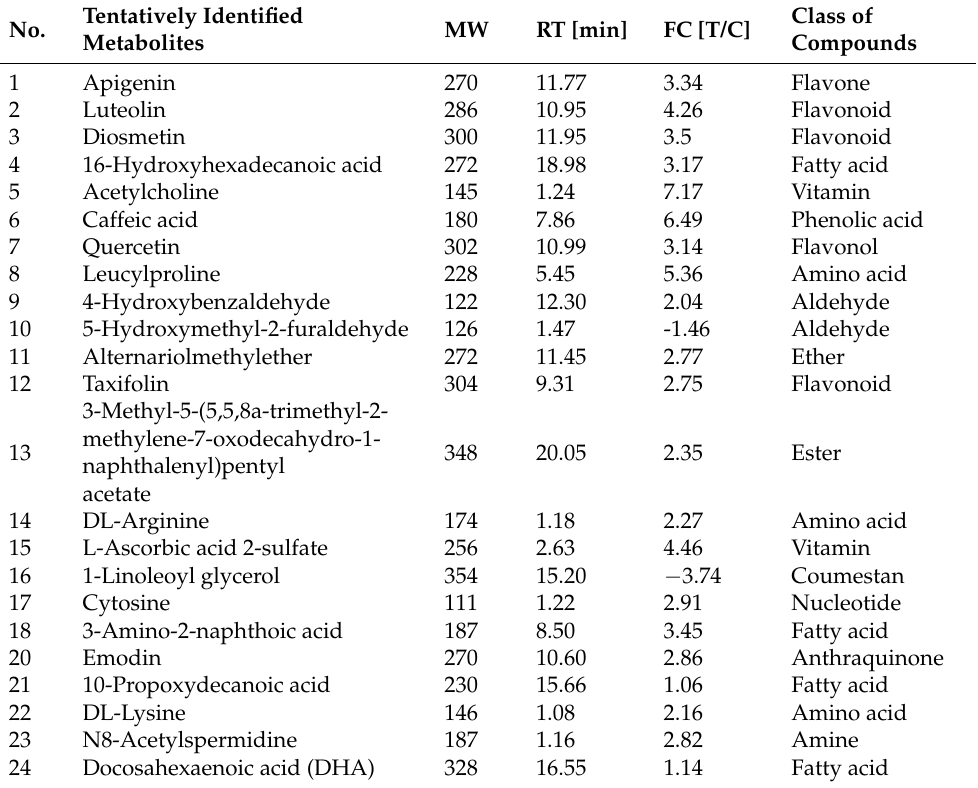
Table 2. Twenty-four significantly discriminant metabolites of the Lp-fermented B. papyrifera product (FBP) under practical condition based on mzCloud >